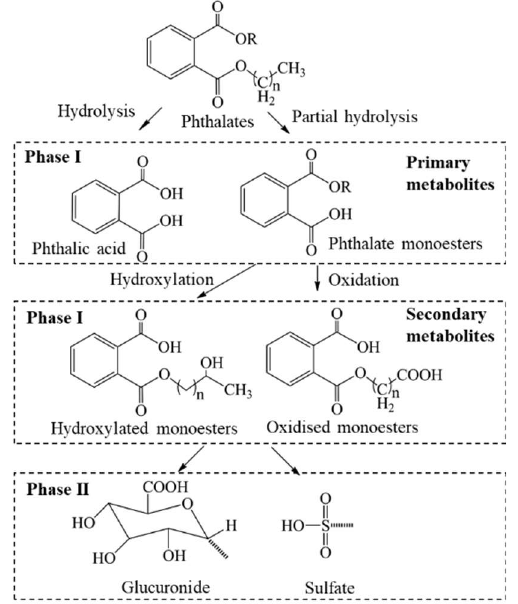
Figure 2. Metabolic pathways of phthalate esters in humans.